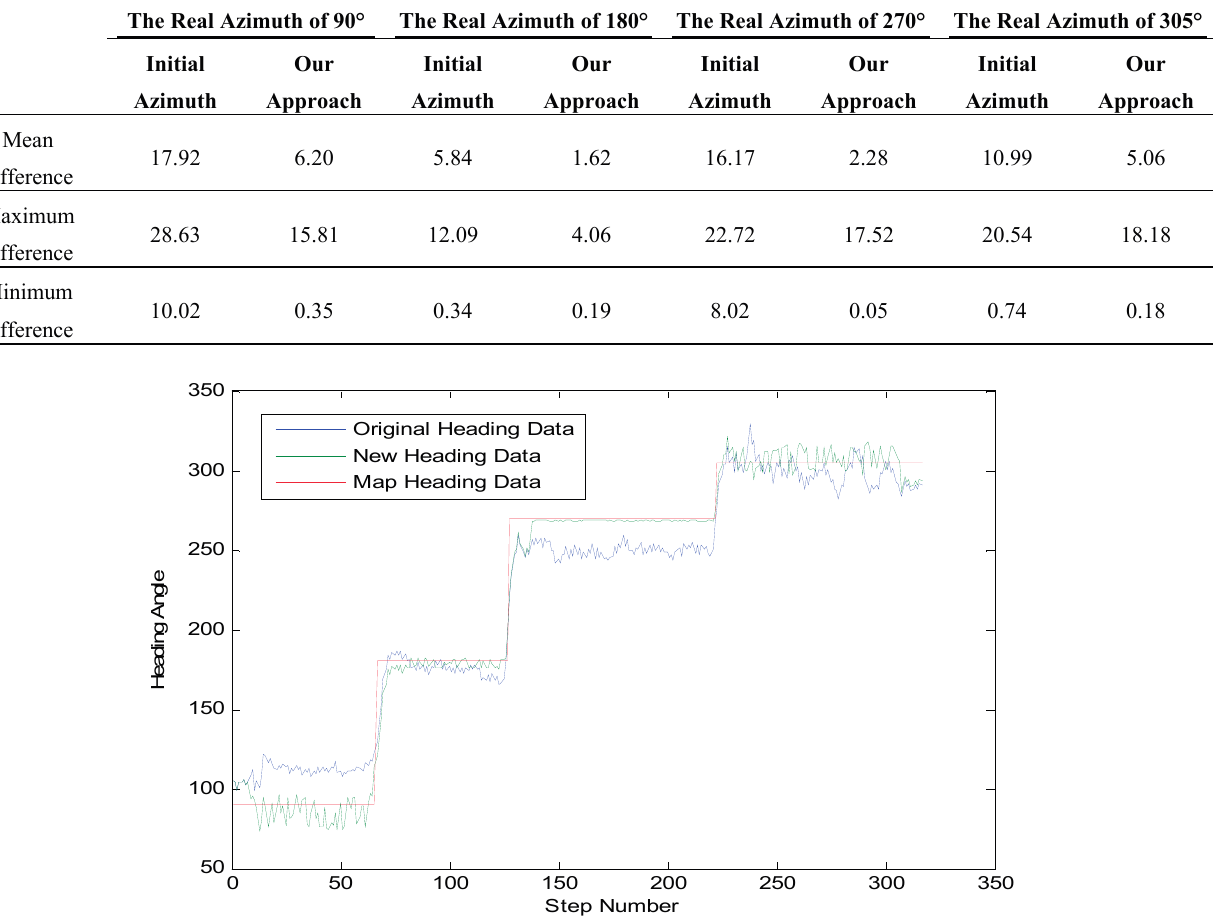
Table 3. Comparative analysis for heading estimation error based on different methods.